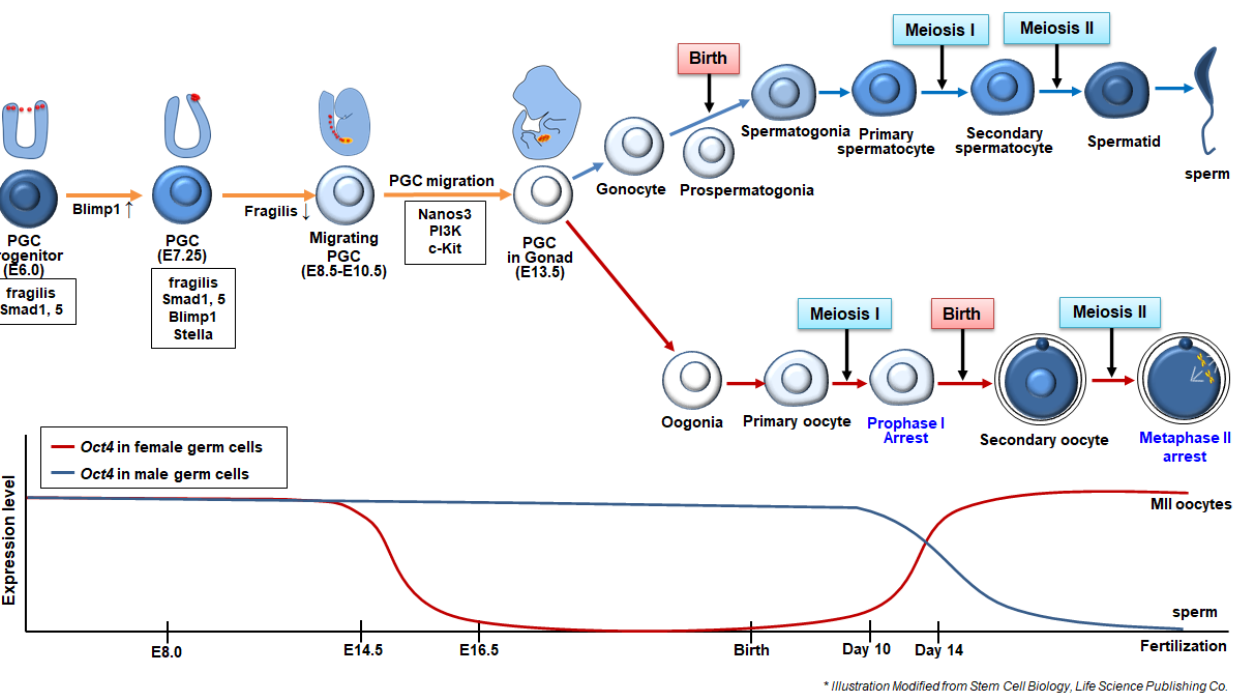
Figure 1. Summary of in vivo developmental process for the formation of male and female germ cells and the expression of germ cell-related genes during the germ cell development. Indicated time corresponds to the stages of mouse development. Modified from Stem Cell Biology, Life Science Publishing Co. [27].